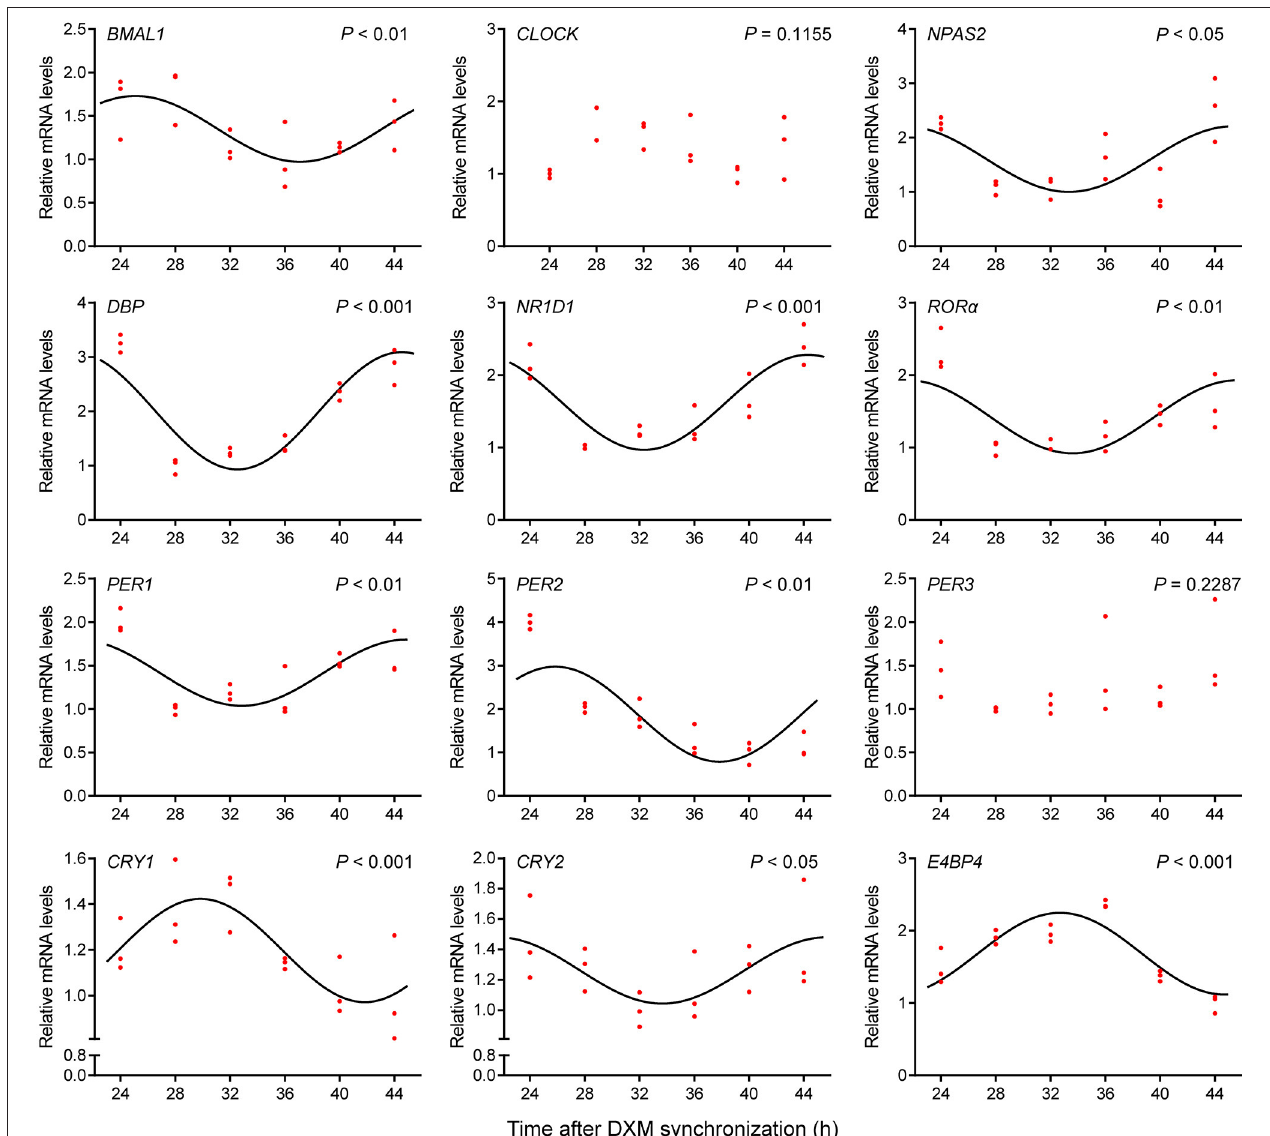
FIGURE 2 | Expression profiles of clock genes in GEFs. Total RNA samples were collected at the indicated times following DXM synchronization. The mRNA expression levels of the clock genes ( BMAL1 , CLOCK , NPAS2 , NR1D1 , ROR α , PER1 , PER2 , PER3 , CRY1 , and CRY2 ) and clock-controlled genes ( DBP and E4BP4 ) were normalized to the housekeeping gene 36B4 and expressed as relative to the nadir. Red dots represent the relative values of each independent determination at the respective time points ( n = 3). Cosinor analysis was utilized to determine the rhythmic expression patterns of the examined genes. The black solid lines show the fitted curves. P < 0.05 was considered to indicate rhythmic expression. GEFs, goat embryonic